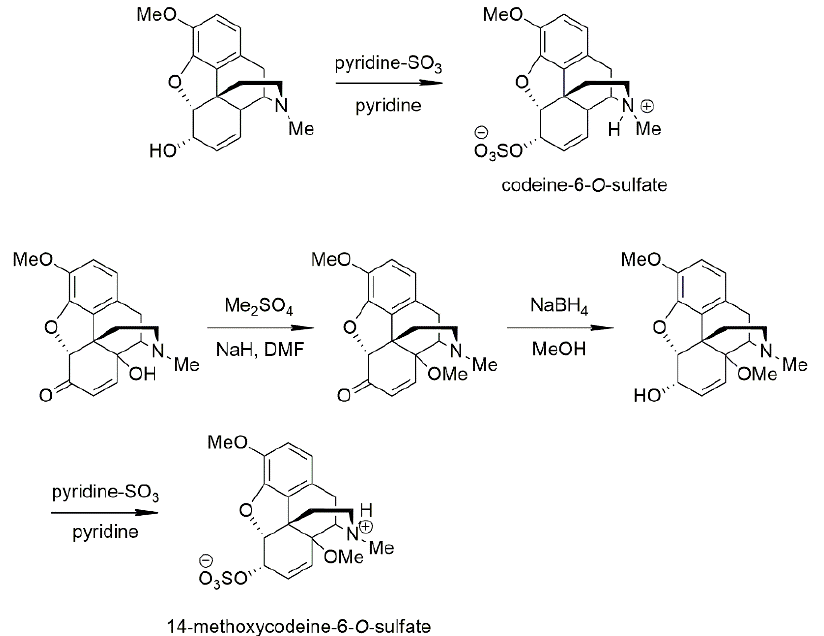
Figure 9. The synthesis of codeine-6- O -sulfate and 14-methoxycodeine-6- O -sulfate. For further details, see Section 4.3.